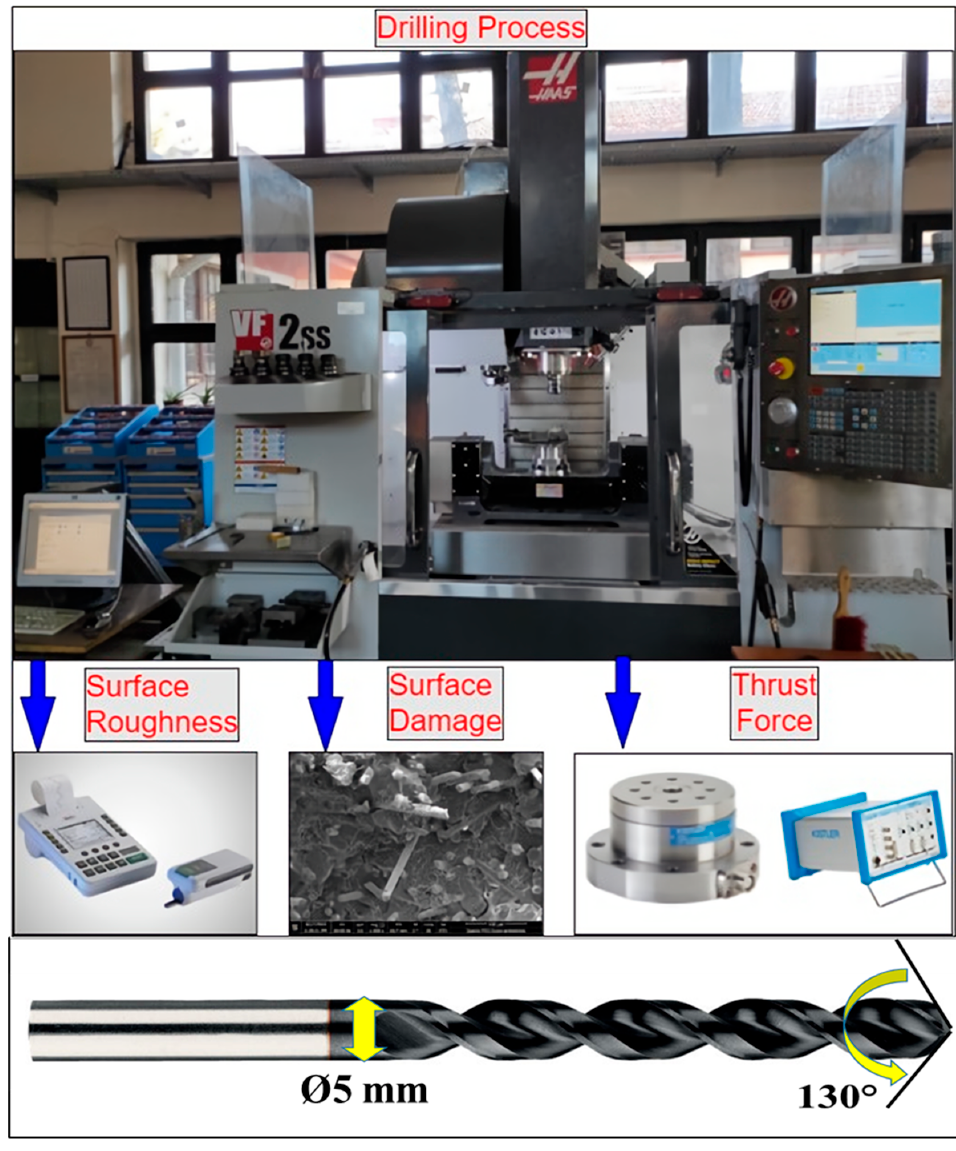
Figure 3. The machining system and flowchart. Table 1. Drilling parameters and their